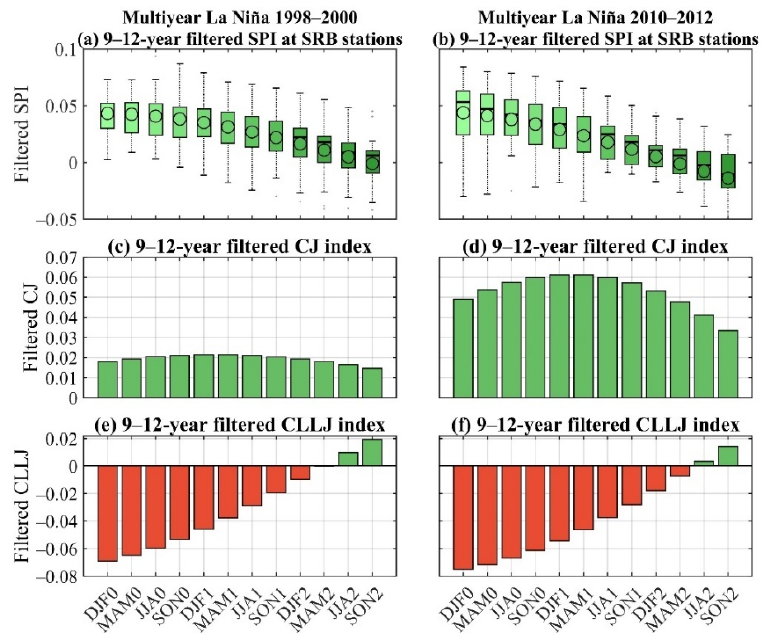
Figure 15. Box plots of the seasonal evolution of the standardized precipitation index (SPI) for the 23 rainfall stations of the Sogamoso River Basin (SRB) during the ( a ) 1998–2000 and ( b ) 2010–2012 La Niña events, as well as seasonal variations of the Chocó jet (CJ) and the Caribbean low ‐ level jet (CLLJ) index during the ( c , e ) 1998–2000 and ( d , f ) 2010–2012 La Niña events filtered at quasi ‐ decadal 9–12 ‐ year scales. The display is the same as in Figure 9.